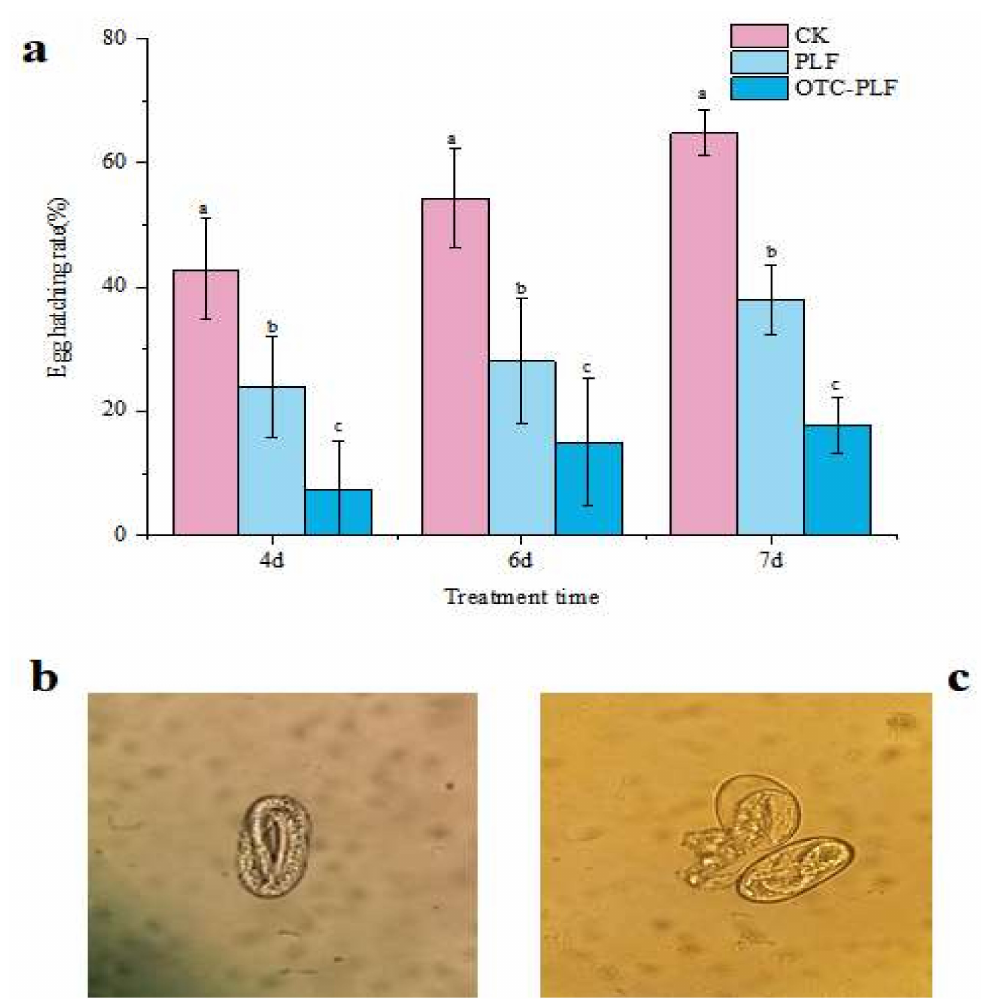
Figure 4. The effects of culture filtrates (OTC-PLF and PLF) on M. incognita egg hatching after 4 d, 6 d, and 7 d ( a ). The state of normal eggs ( b ) and eggs treated with OTC-PLF ( c ). OTC-PLF represents the culture filtrates of Purpureocillium lilacinum combined with by 6-oxychitin. PLF represents the culture filtrates of Purpureocillium lilacinum . CK represents the blank control. Different letters represent significant differences ( p < 0.05) according to Duncan’s